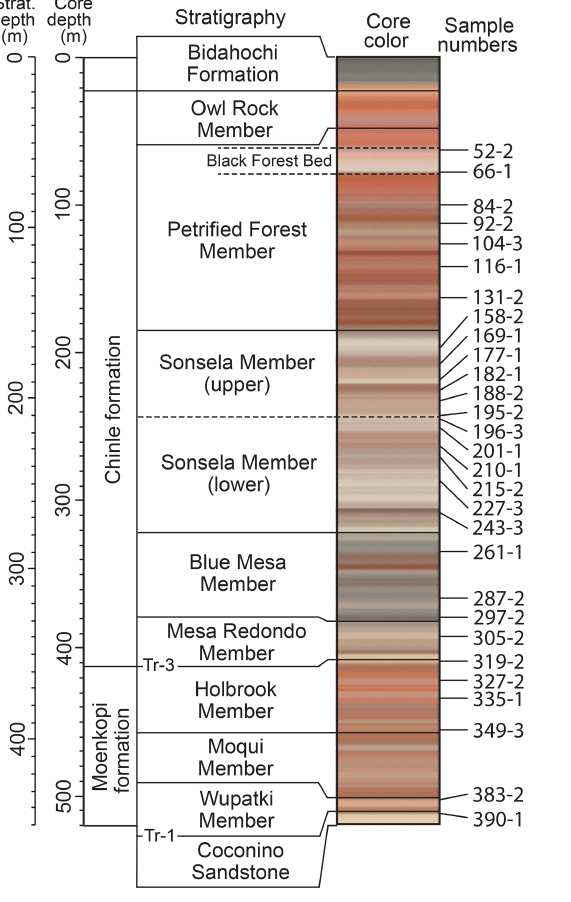
Figure 2. Strata encountered in the Colorado Plateau Coring Project (adapted from Olsen et al., 2018). Sampled horizons are shown relative to core depth, stratigraphic depth, and stratigraphic nomenclature relevant for the Petrified Forest region. Detailed de- scriptions of samples are provided in Table S1; images of the sam- pled material are presented in Sect.